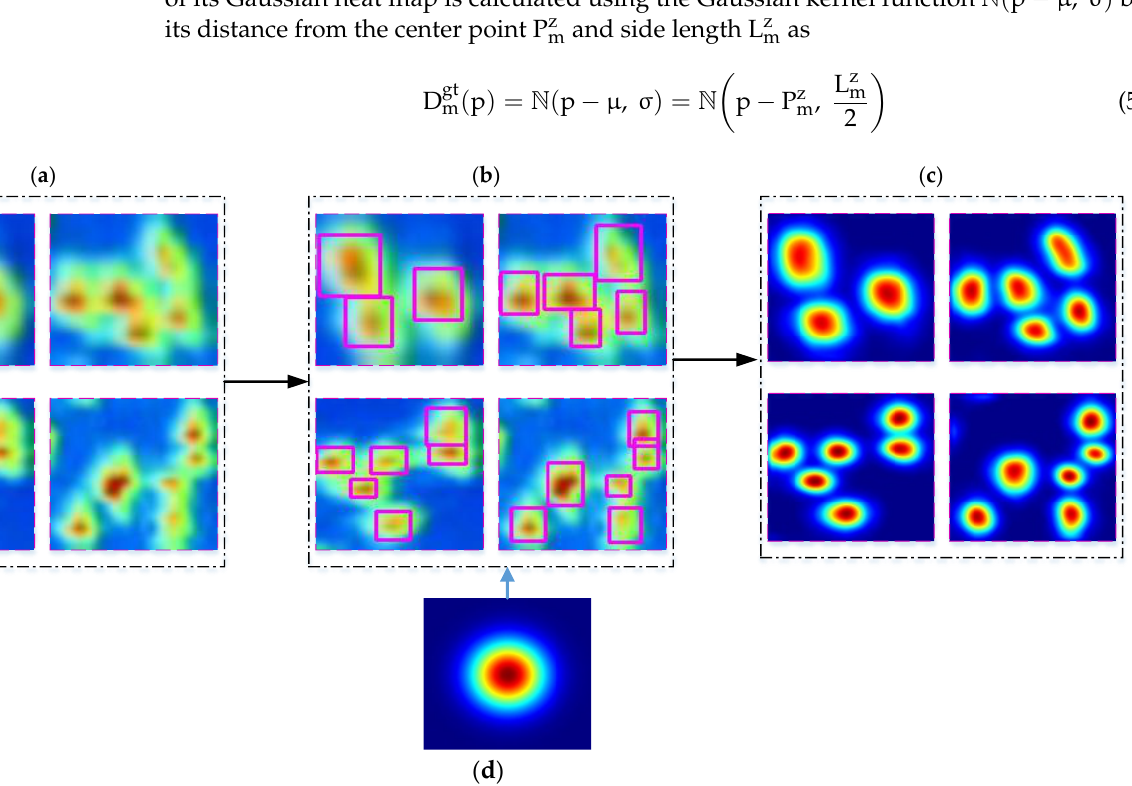
Figure 3. Gaussian heat map generation process, ( a )bird gathering or overlapping region image; ( b ) targets manually annotated with rectangle boxes; ( c ) the resulting Gaussian heatmap ground truth; ( d ) 2D Gaussian kernel.